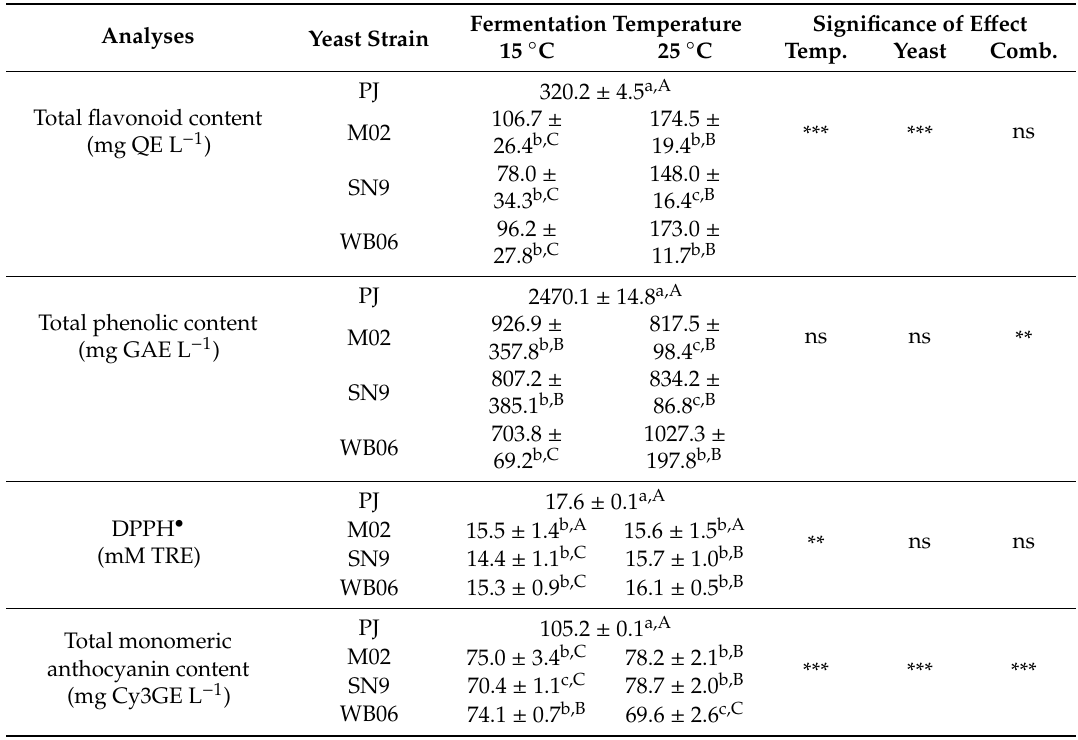
Table 2. E ff ect of yeast and fermentation temperature on the antioxidant activity and phenolic compounds of pomegranate alcoholic